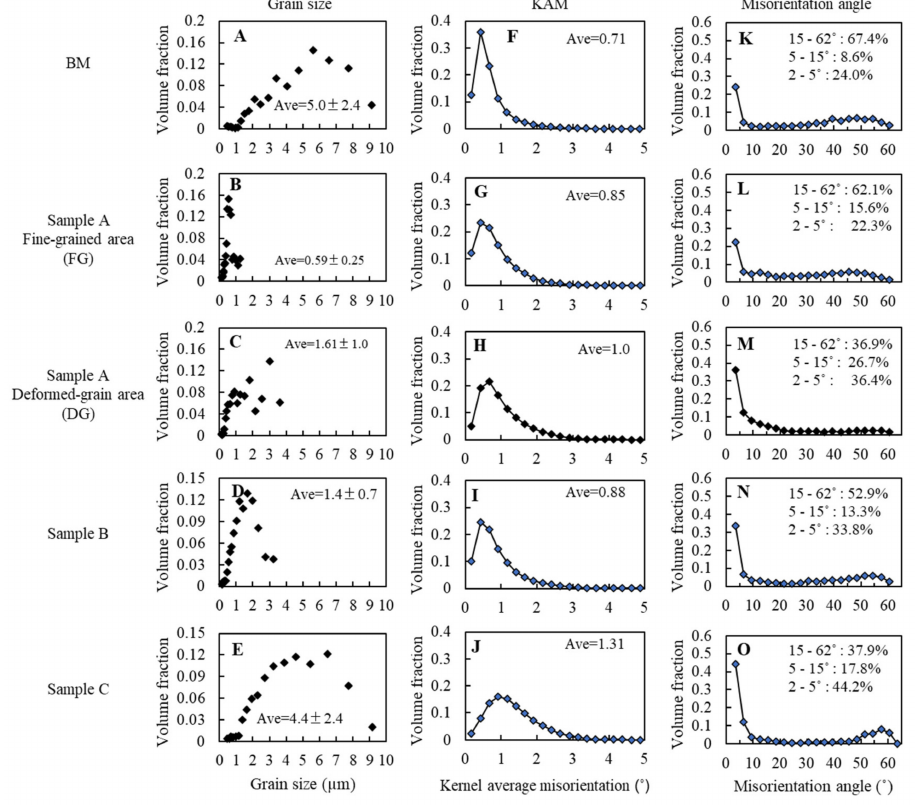
Figure 14. Comparison of grain size, KAM, and misorientation angle characterized by EBSD: ( A ), ( F ), and ( K ) are for the BM; ( B ), ( G ), and ( L ) are for the FG zone of sample A; ( C ), ( H ), and ( M ) are for the DG zone of sample A; ( D ), ( I ), and ( N ) are for sample B; and ( E ), ( J ), and ( O ) are for sample